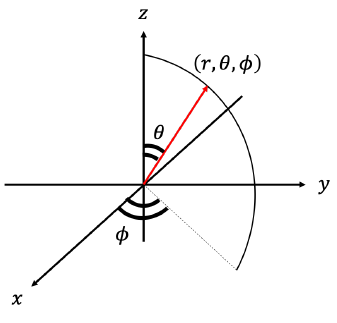
Figure 6. Spherical coordinate system.